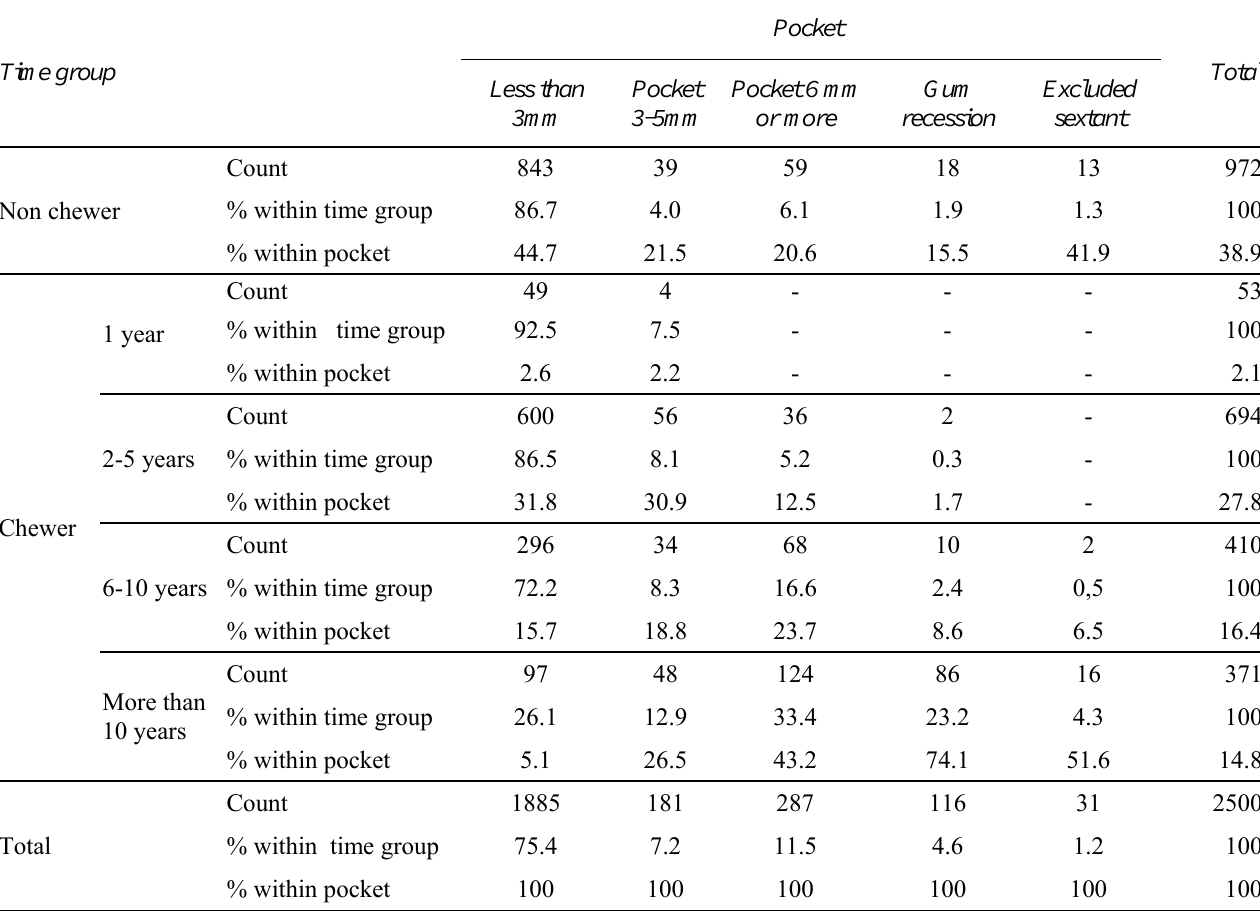
Table 4: The effect of duration of chewing on gum recession and periodontal